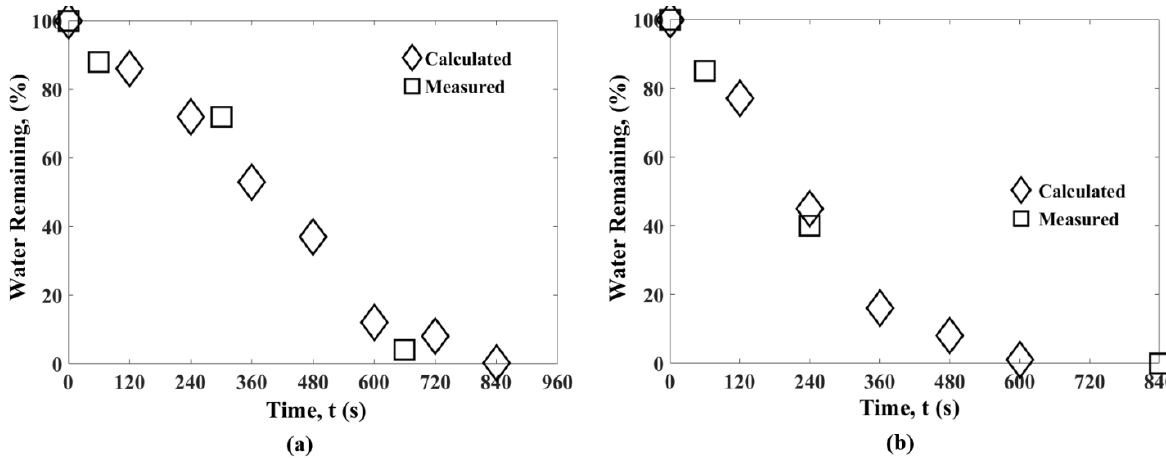
Figure 10. Comparison of the moisture loss of rectangular foam sample with a 𝑣 = 100 cm 3 at 𝑃 𝑖𝑛 = 30% ( a ) and 𝑃 𝑖𝑛 =